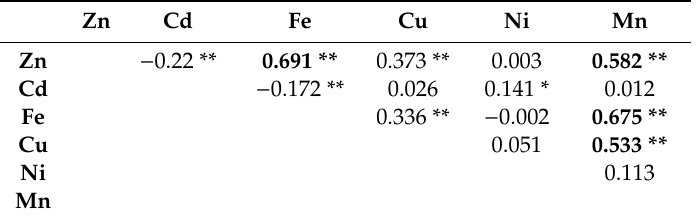
Table 3. Spearman correlations coe ffi cients for the metal concentration in bulk precipitation (moderate to strong correlations > 0.5 are shown in bold).